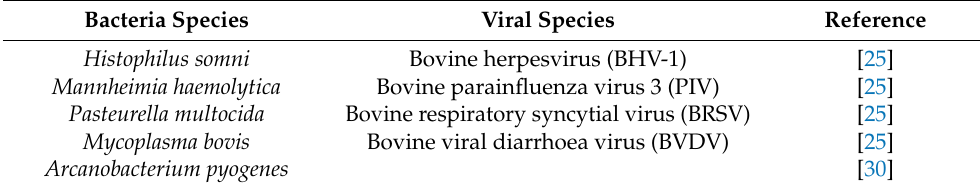
Table 1. Major bacterial and viral species associated with BRD. Bacteria